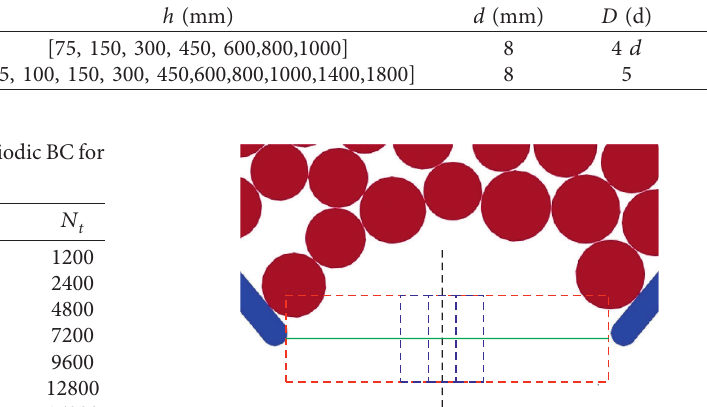
Table 2: Simulations performed without periodic boundary condition to study the clogging probability.